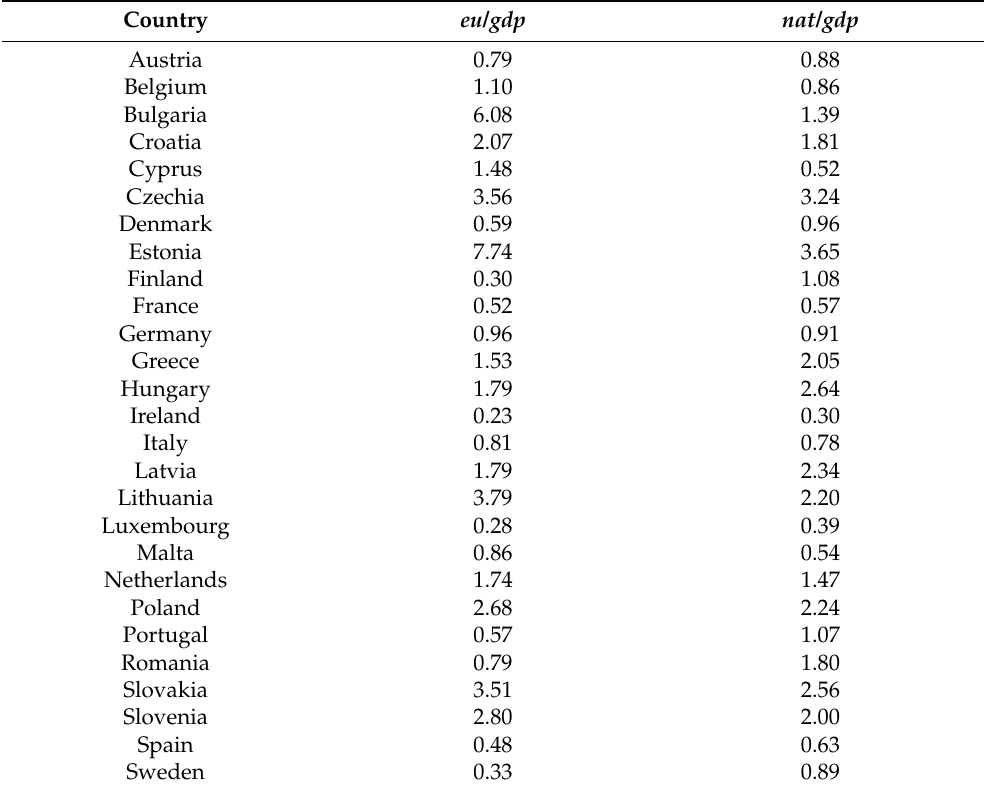
Table 8. Ratios referring to each country’s relevant footprint in the domain usage landscape. Country eu/gdp